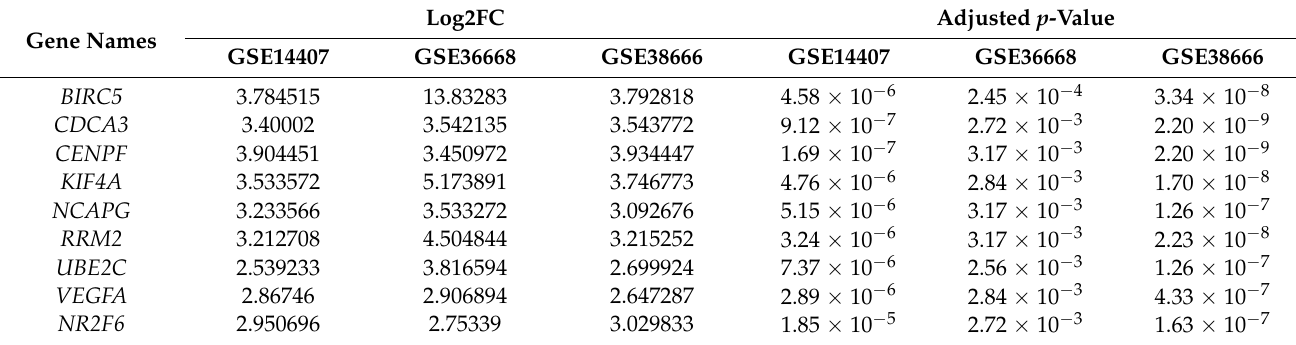
Table 2. Up-regulated DEGs in serous ovarian cancer of the GEO datasets.